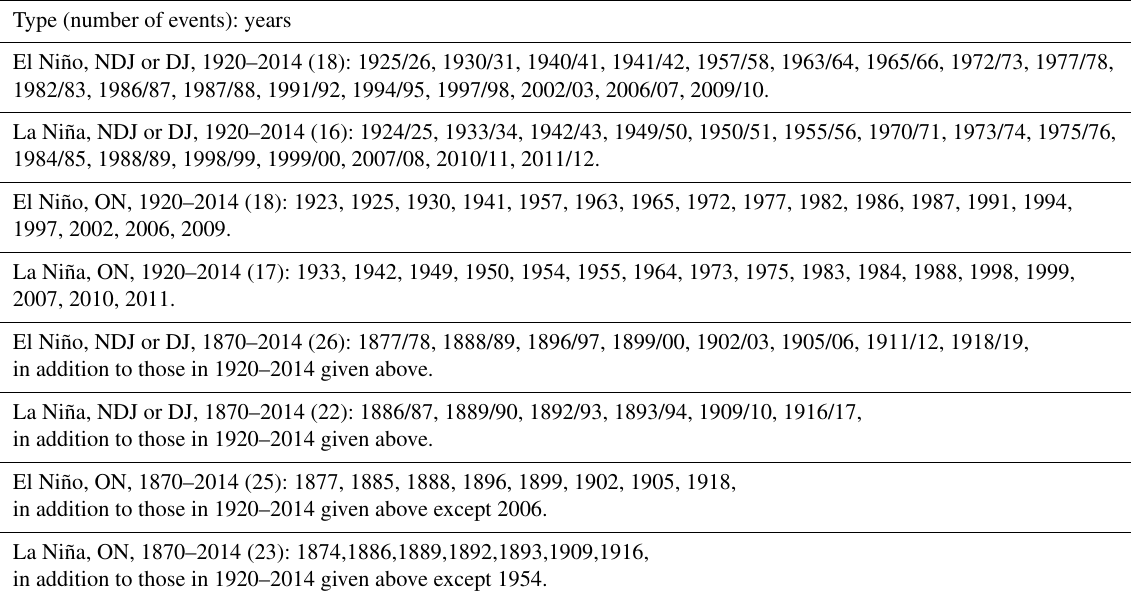
Table 1. ENSO events based on Nino3.4 used in the composite calculations. Type (number of events):